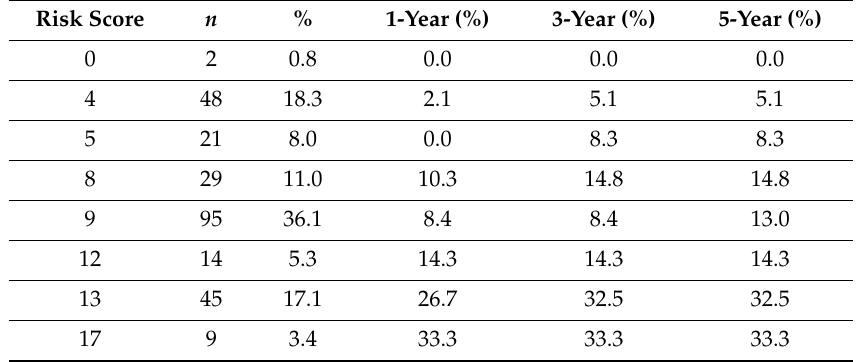
Table 4. Cumulative incidences of lower extremity lymphedema according to risk